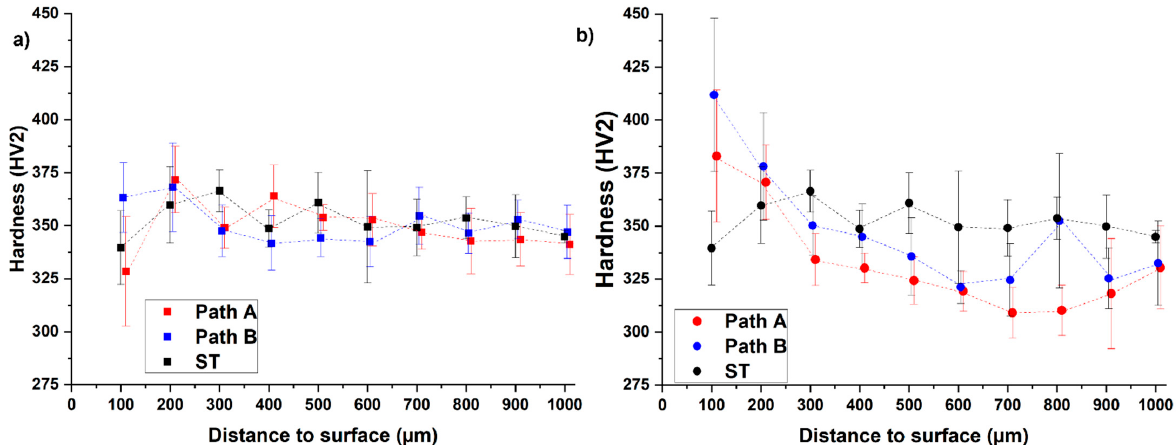
Figure 4. Measured hardness curves after hydrogenation ( a ) and dehydrogenation ( b ) for both paths in comparison to its initial condition (ST, solution treatment A).